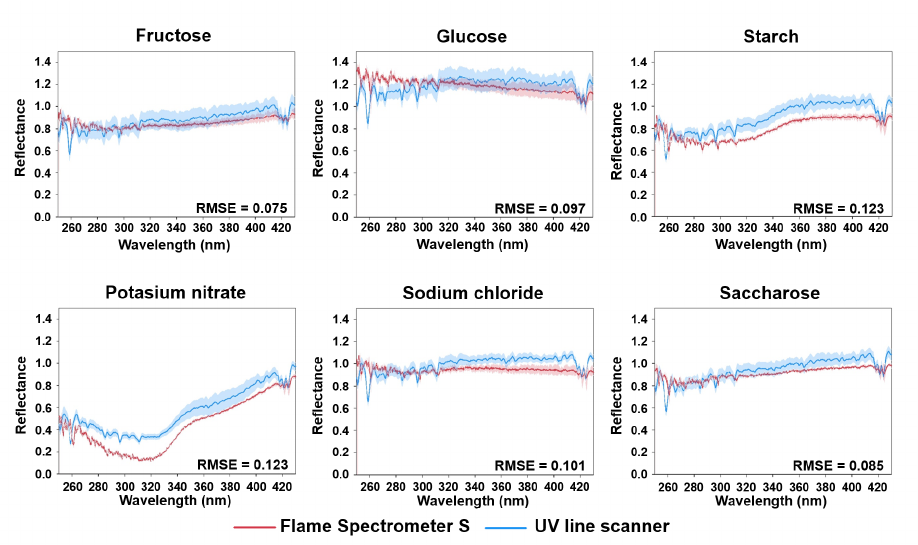
Figure 2. Spectral signatures of fructose, glucose, saccharose, potassium nitrate, sodium chloride and starch, measured with UV line scanner and non-imaging Flame Spectrometer S. Light-blue and red areas around the mean spectra indicate the standard deviation. RMSE was calculated for each substance comparing both